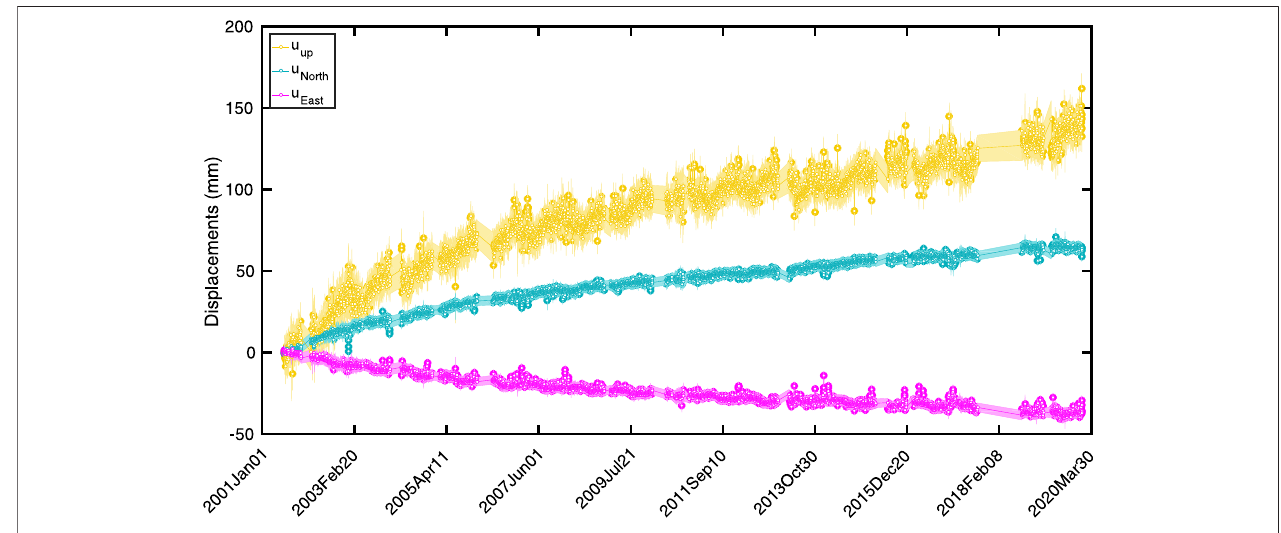
FIGURE 2 | North ( U North ), east ( U East ) and vertical ( U up ) components of the continuous GPS displacements at HUSB.